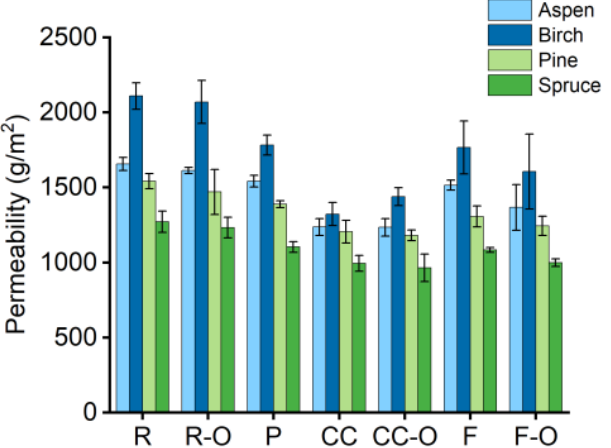
Figure 2. Water vapor permeability (g/m 2 ) of aspen, birch, pine and spruce with reference to mass at 30% RH. R = reference, P = paint, CC = contact-charred, F = flame-charred, O = oil added to respected surface. Error bars depict standard deviation.